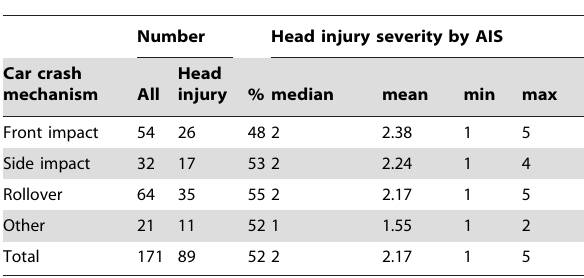
Table 5. Number, proportion, and severity of